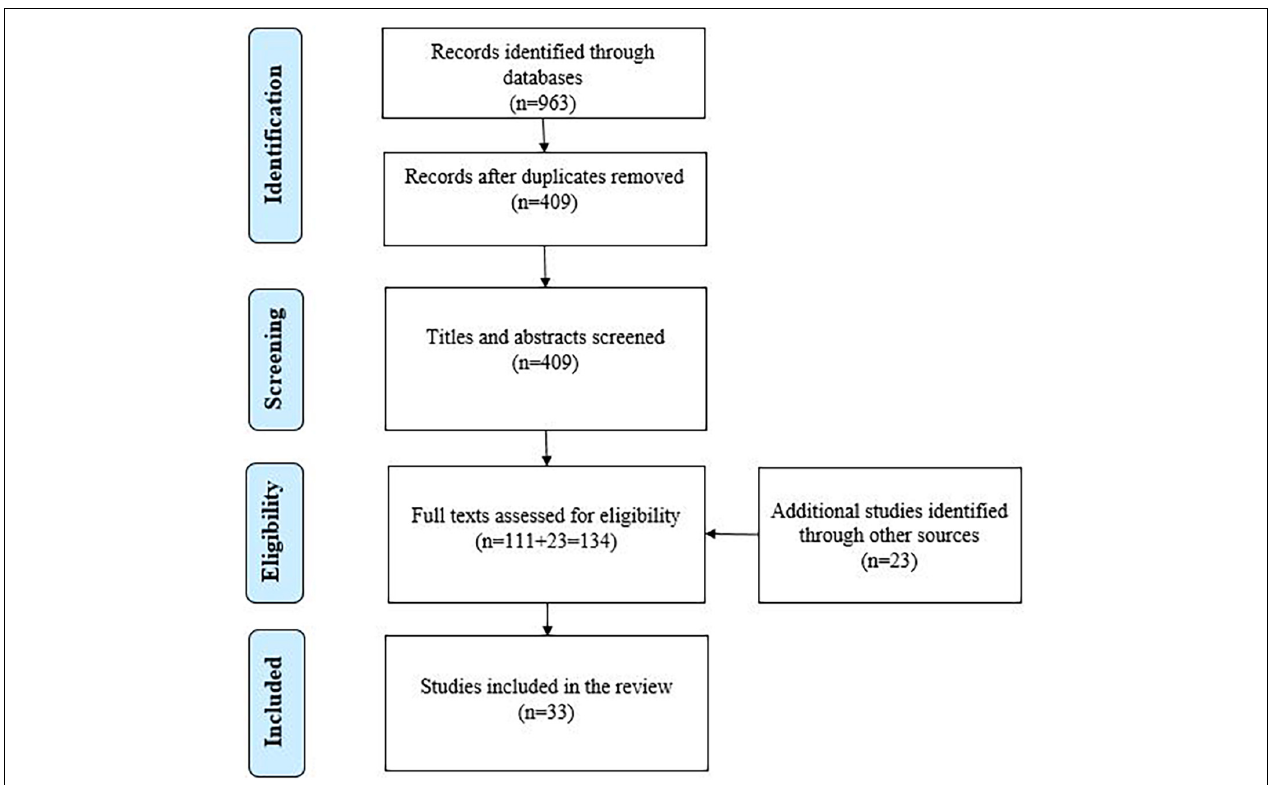
FIGURE 2 | Selection process of the studies.